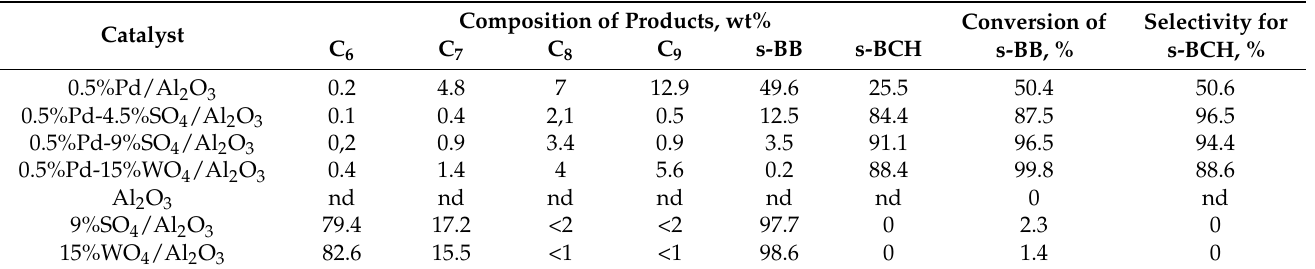
Table 2. Results of s-BB hydrogenation in an autoclave at 140 ◦ C and 20 atm. Composition of Products, wt% Conversion Catalyst